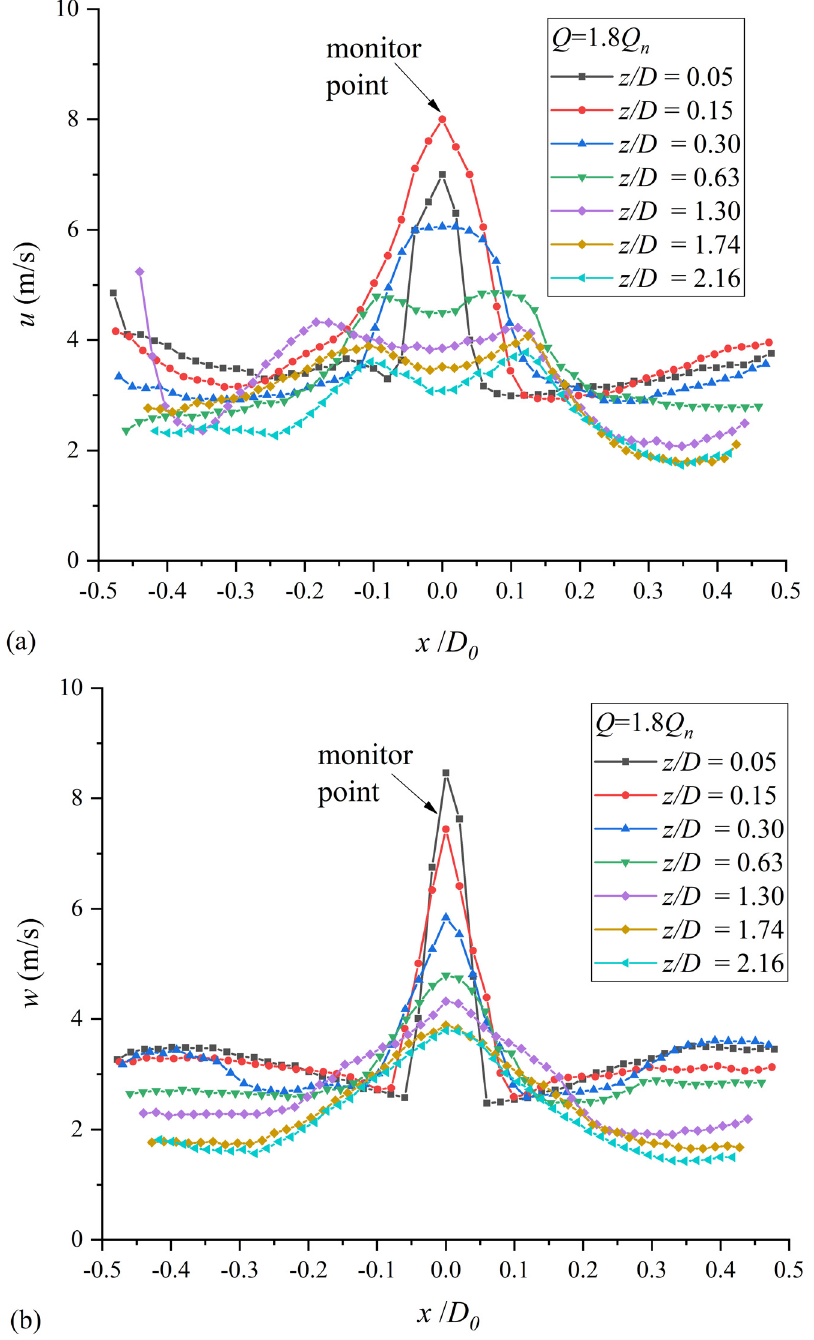
Figure 8. Profiles of the RMS velocity component fluctuations at different distances from the runner at a constant runner speed ω n : ( a ) Axial component; ( b ) Tangential component. Overload operating regime with Q = 1.8 Q n .